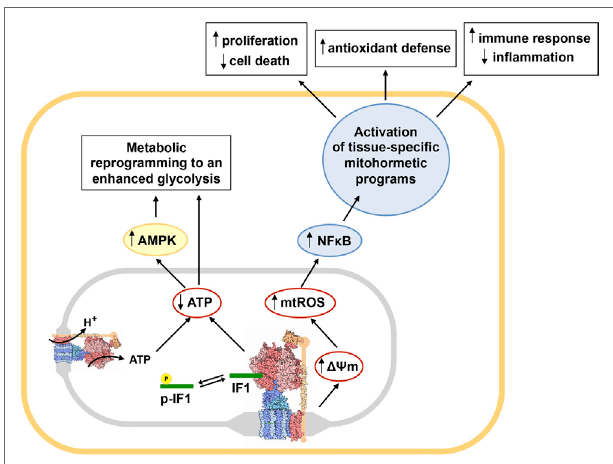
FiGURe 2 | Main metabolic and redox circuits regulated by the inhibition of the H + -ATP synthase by inhibitory factor 1 (IF1). Dephosphorylated IF1 (green rod) inhibits the H + -ATP synthase (structure) when bound to the enzyme, while IF1 phosphorylation (yellow) prevents its binding and hence its inhibitory activity (59). The inhibition of a relevant pool of molecules of H + -ATP synthase by IF1 reduces cellular ATP availability, promoting metabolic reprogramming to an enhanced glycolysis and the activation of AMPK (71–73). Moreover, IF1 inhibition of the H + -ATP synthase triggers mitochondrial hyperpolarization because prevents H + backflow through the enzyme enhancing the production of mitochondrial ROS (mtROS) that activate the canonical NF κ B pathway (61, 72, 73). Activation of NF κ B triggers the induction of different tissue-specific mitohormetic programs in the nucleus of the cell. In colon cancer cells overexpressing IF1, these programs favor proliferation, invasion, and resistance to cell death (61). In transgenic mice overexpressing IF1 in neurons or liver, promote the activation of survival pathways and antioxidant defenses (71, 72). In transgenic mice overexpressing IF1 in the intestine, the activated programs modulate the immune response of the tissue, favoring the development of an anti-inflammatory phenotype (73). Abbreviations: p-IF1, phosphorylated IF1; AMPK, AMP-activated protein kinase; NF κ B, nuclear factor kappa B. The structure of the H + -ATP synthase was obtained from